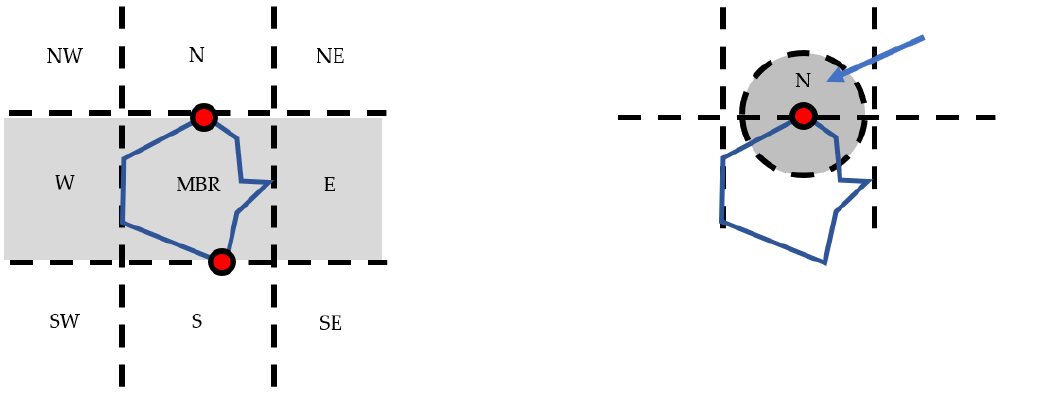
Figure 9: Example used for Theorem 3.1. For the object A to meet object B , object A (with non-zero thickness as it is a simple region) is forced to pass through the common point between MBR( B ), B , and N B without intersecting either B or N B . The same is true for the corresponding southern